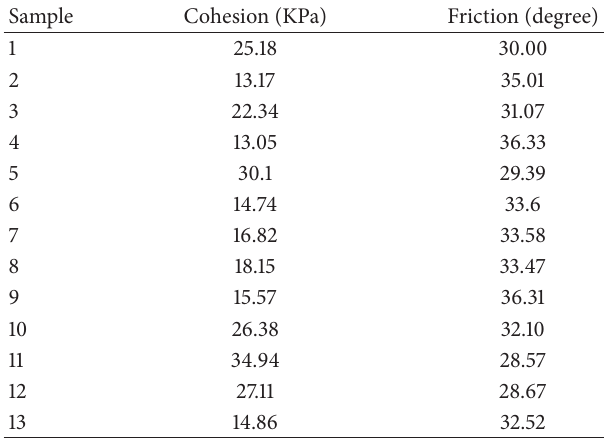
Table 3: Distribution of cohesion and angle of internal friction in different